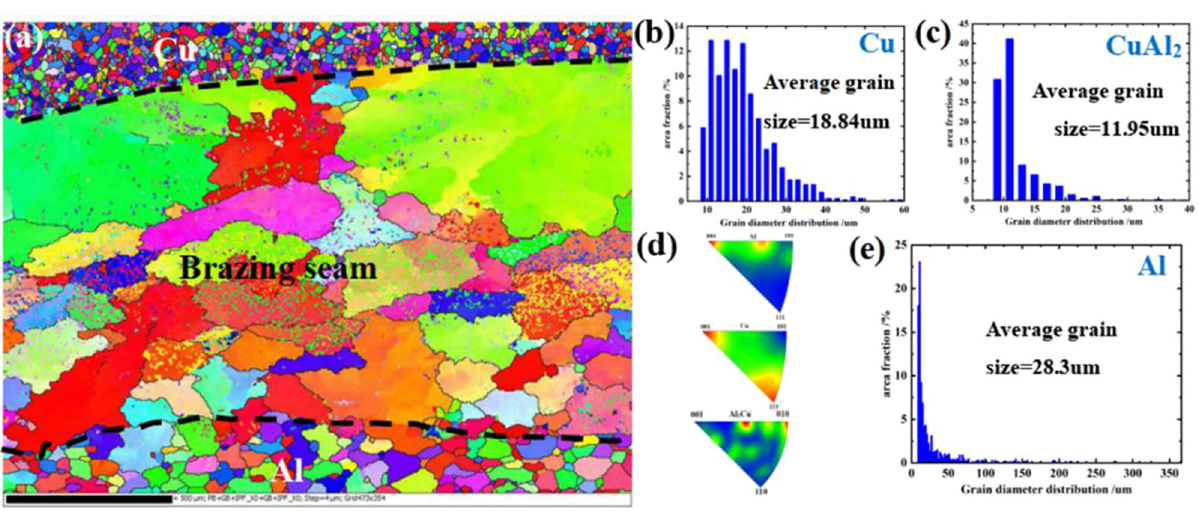
Figure 7: BAl88Si brazing joint EBSD image: ( a ) IPF map of the interface region, ( b ) grain size diagram of Cu, ( c ) grain size diagram of CuAl 2 , ( d ) inverse polar diagram of CuAl and CuAl ( e ) grain size diagram of 2 and